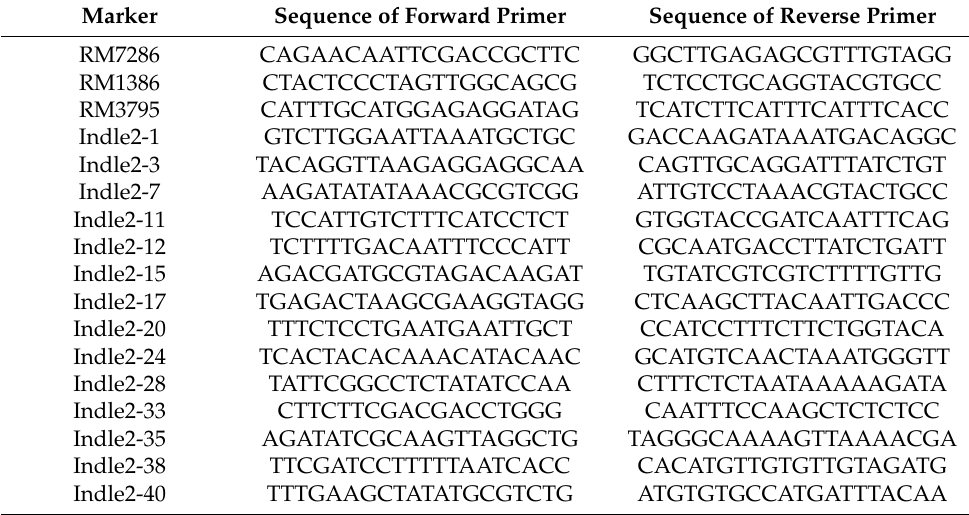
Table 3. Indel and SSR molecular markers used for fine mapping of qra2 . Marker Sequence of Forward Primer Sequence of Reverse